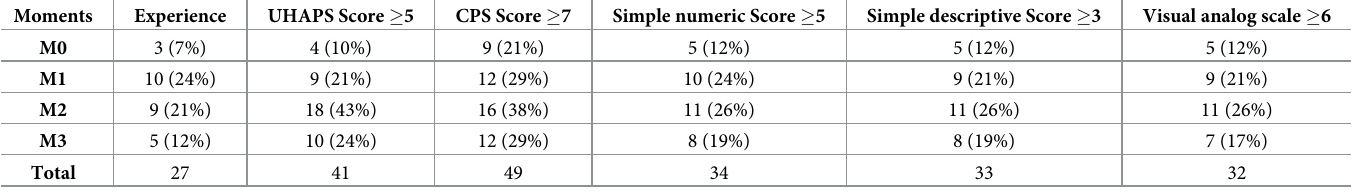
Table 11. Number of horses requiring rescue analgesia would be indicated based on clinical experience and the Youden index.